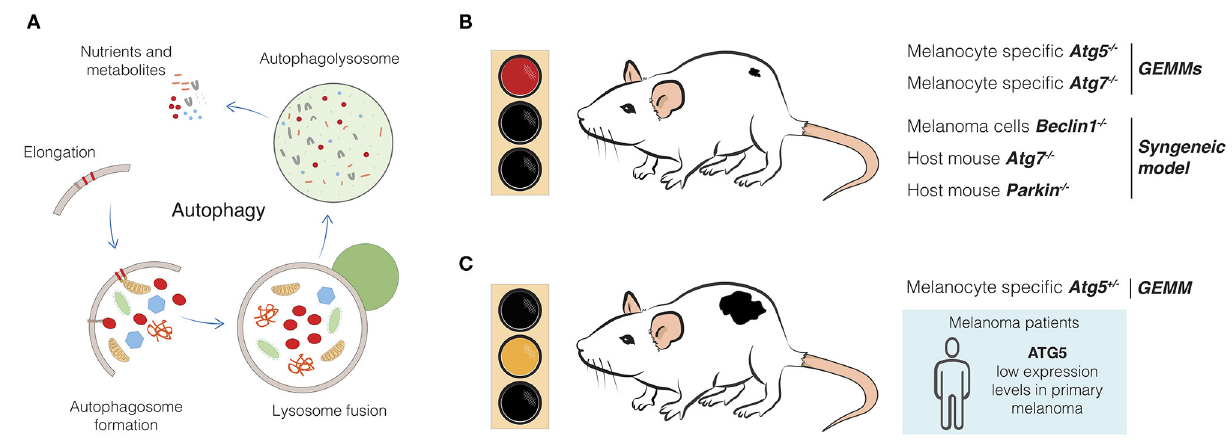
FIGURE 1 | Effects of autophagy genes alteration in melanoma development. (A) Autophagy is a complex, dynamic, and well-conserved degradative process which involves several molecular players and steps. Starting from the elongation of the phagophore, which leads to the autophagosome formation, the cytoplasmic material is eventually engulfed and degraded in the autophagolysosome after fusion with the lysosome (11). New building blocks and metabolites are now released and available for the cell. (B) Melanomagenesis from melanocytic nevi is blocked upon melanocytic-specific depletion of autophagy genes, such as Atg5 and Atg7 in GEMMs ( 64, 65). Syngeneic models displayed similar evidence, as in the case of host mice injected with Beclin1 -engineered B16-F10 melanoma cells (67) or upon injection of melanoma cells in Atg7 - and Parkin - genetically engineered mice ( 68, 69). (C) Melanoma development is favored upon single-copy loss of Atg5 in GEMM (65). Primary tumors from melanoma patients have been found to have reduced expression of ATG5, if compared to melanocytic nevi (17). Therefore, impaired autophagy, as well as putative additional functions of Atg5 can induce